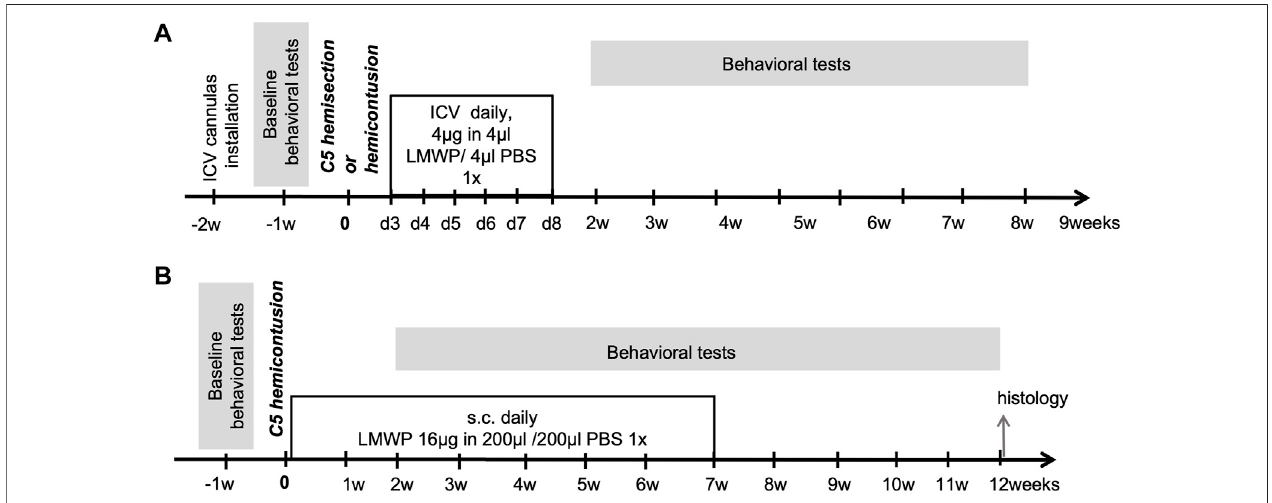
FIGURE 1 | Protocols of in vivo experiments. (A) Hemisection and hemicontusion experiments using ICV delivered LMWP. (B) Hemicontusion experiments using systemic delivery of LMWP.